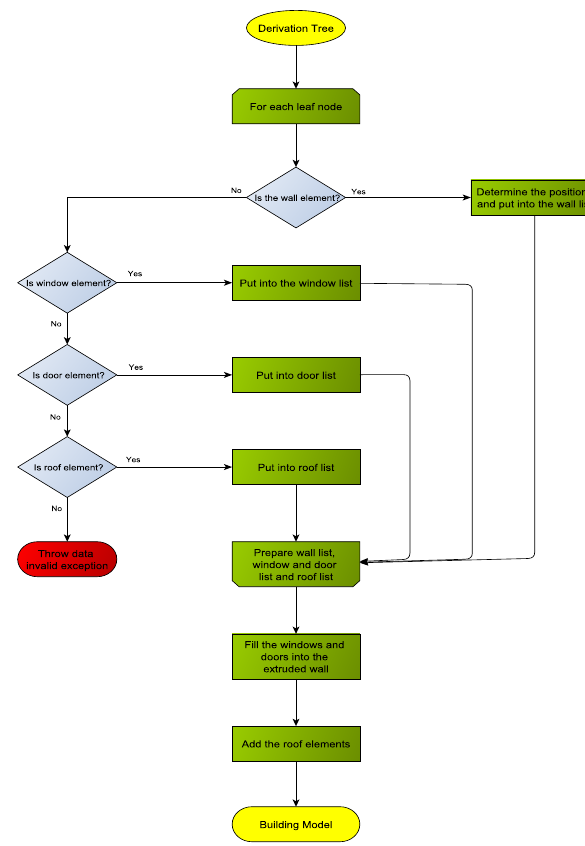
Figure 7: The main flow to generate the building model from the grammar-based interpretation